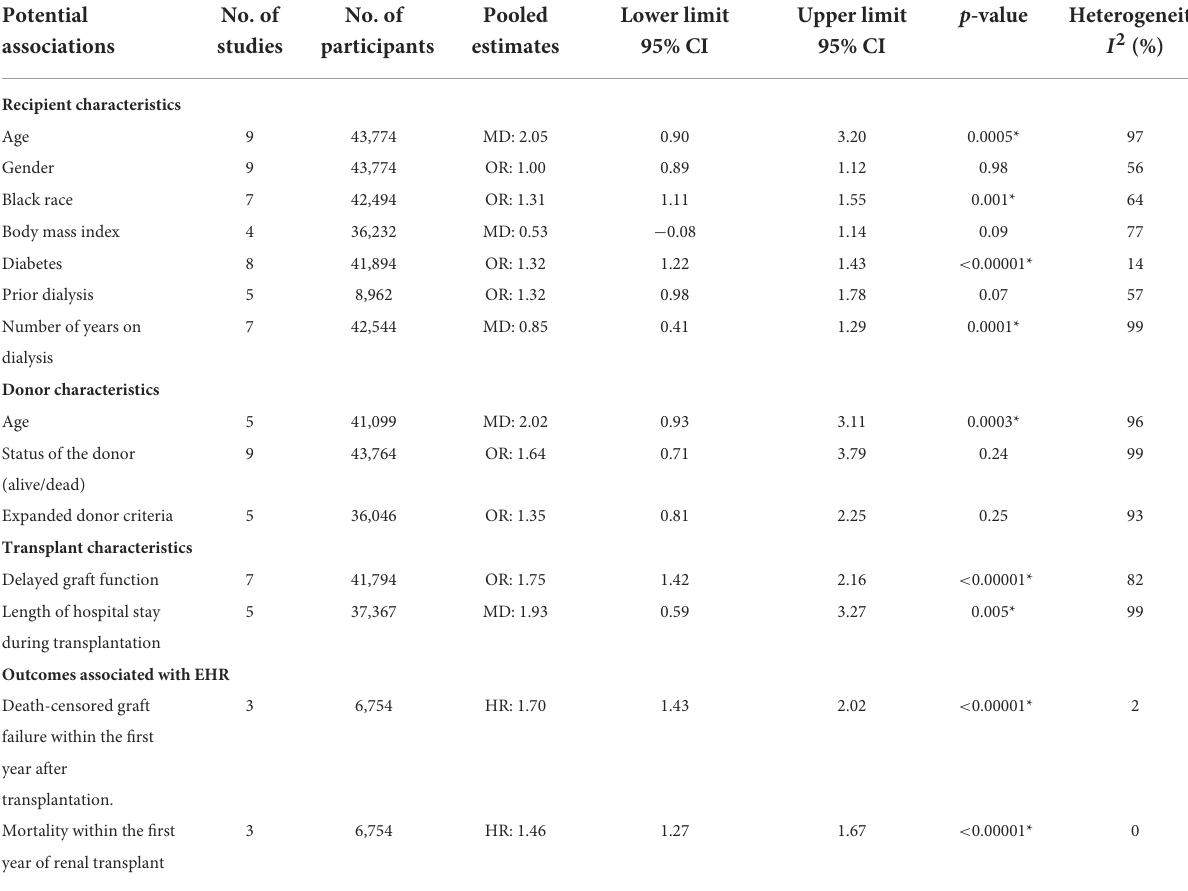
TABLE 2 Meta-analysis of the risk factors and outcomes associated with early hospital readmission (30-day) after kidney transplantation. Potential associations